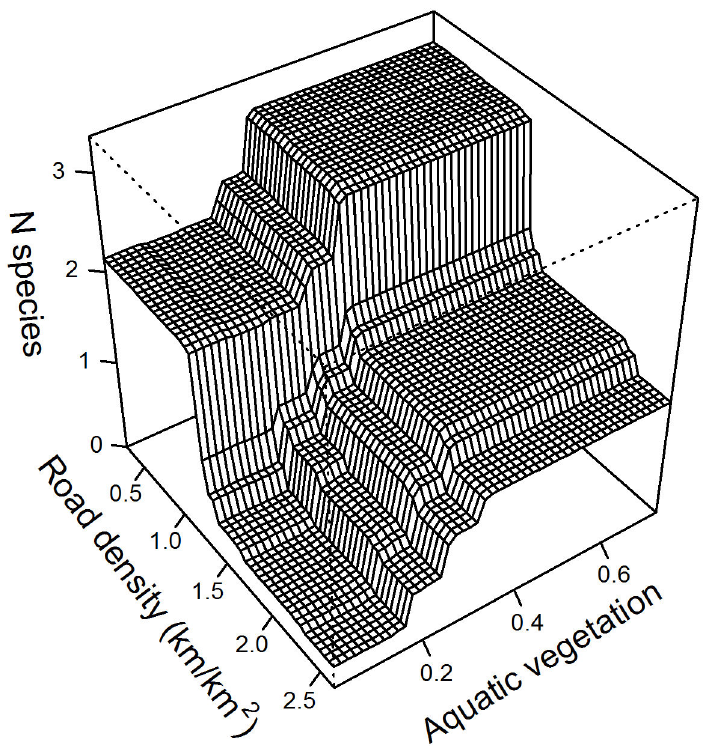
Figure 3. Interaction between road density and aquatic vegetation in influencing species richness. Road density values log- transformed on the